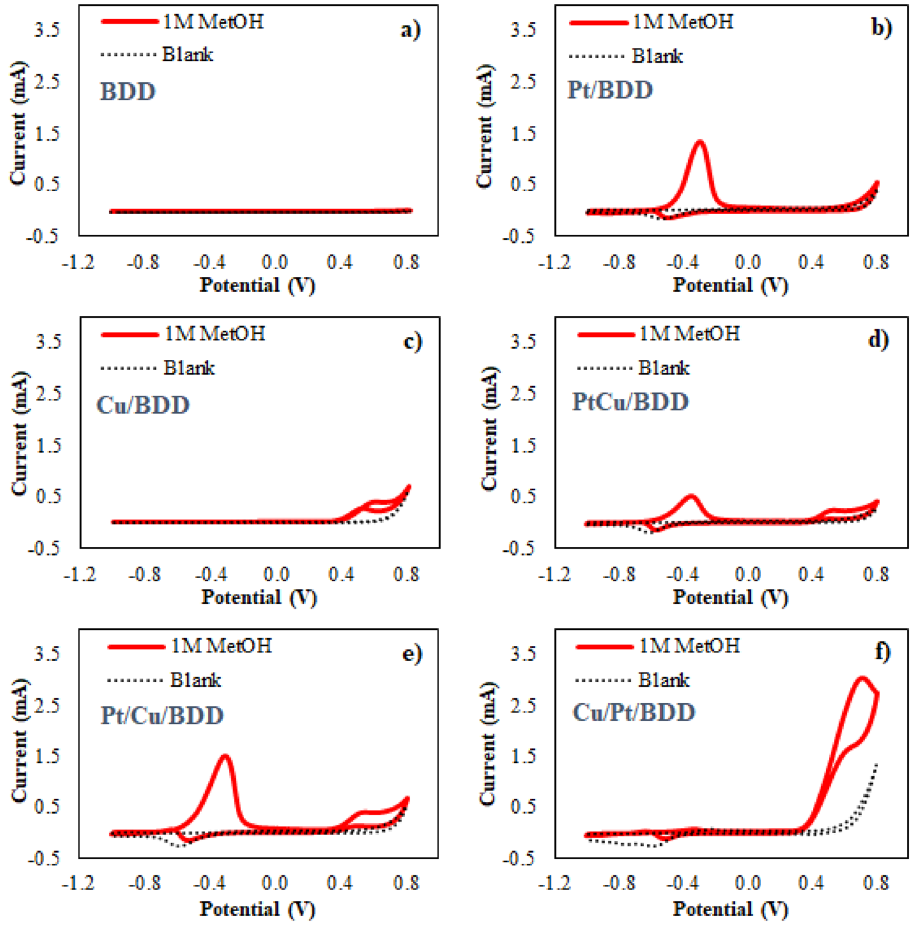
Figure 1. Cyclic voltammogram of 1 M MetOH in 0.1 M NaOH on the ( a ) bare BDD electrode compared with the modified electrodes: ( b ) Pt/BDD, ( c ) Cu/BDD, ( d ) PtCu/BDD, ( e ) Pt/Cu/BDD, and ( f ) Cu/Pt/BDD electrodes. Scan rate: 100 mV/s. All electrodes were prepared via multiple-step deposition